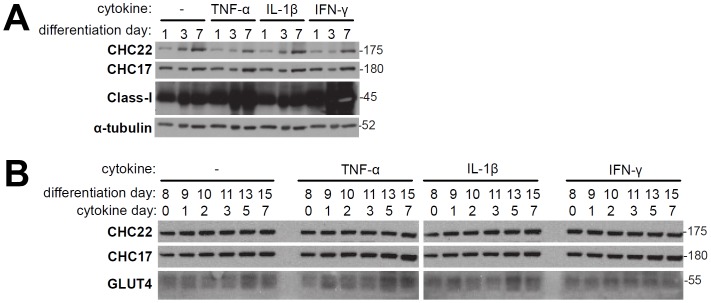
Effect of cytokines on human myoblast or myotube cultures.A) LHCNM2 human skeletal muscle myoblasts were cultured under differentiation conditions for the indicated number of days in the presence or absence (−) of the indicated cytokines. Cell lysates prepared on the indicated day were analyzed by immunoblotting for the protein indicated at the left. B) Experiment as in A with addition of indicated cytokines on differentiation day 8 when myotubes had formed. Molecular mass (kilodaltons) of the proteins detected is indicated at the right.